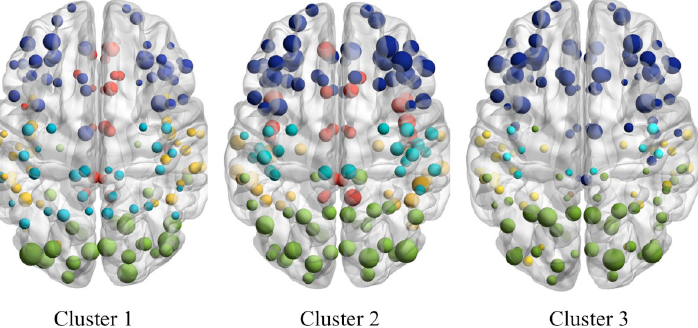
Fig 4. Cortical thickness network visualization. Visualization of cortical thickness networks for each neurocognitive cluster. Nodes are plotted by module membership. Greater node size reflects higher node degree (i.e., a greater number of connections). Module 1 (limbic lobe) = red; Module 2 (temporo-occipital) = yellow; Module 3 (occipital) = green; Module 4 (parieto-frontal) = light blue; Module 5 (frontal) = dark blue.